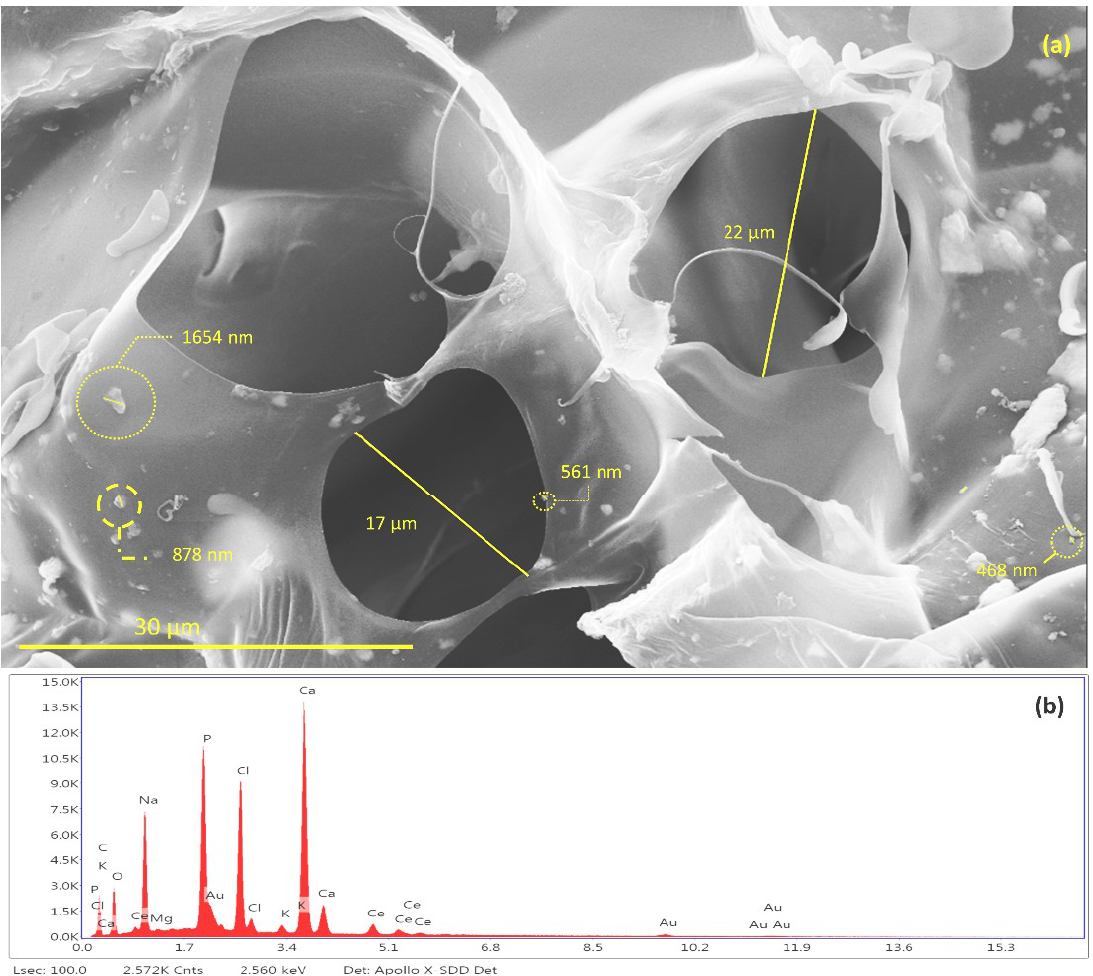
Figure 11. Frequency of distribution of pore size of Ce-HApCG biocomposite.